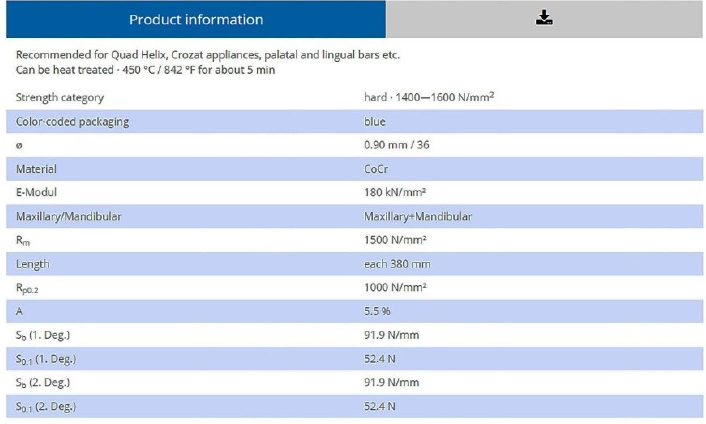
Figure 1. Technical characteristics of Co-Cr springs [12].